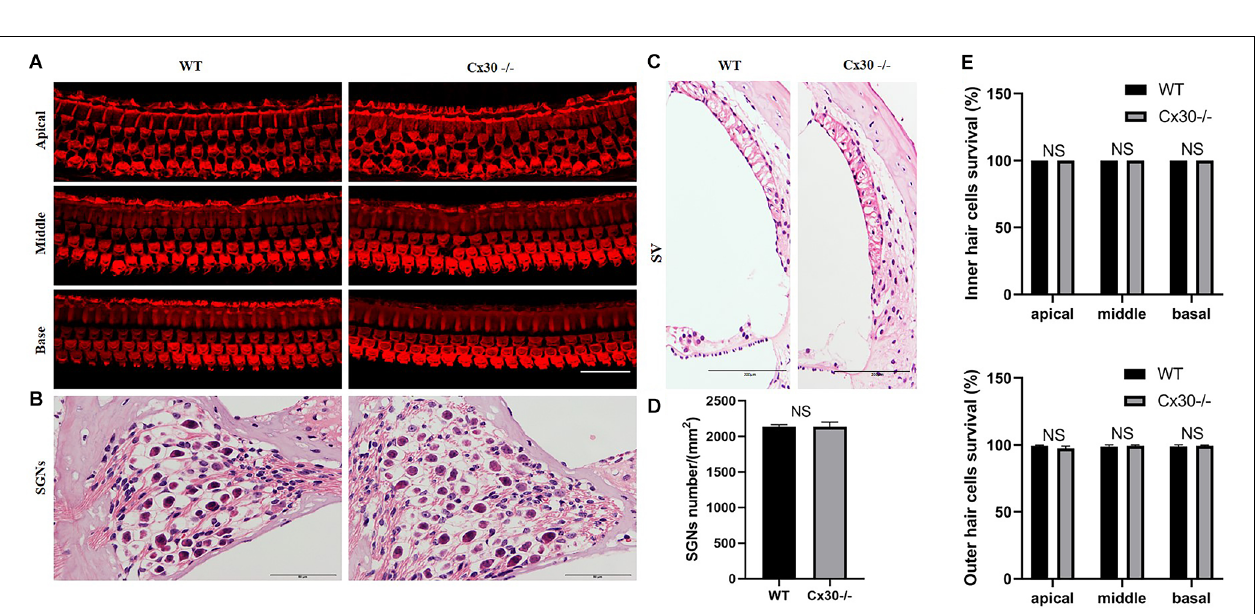
FIGURE 3 | The microscopic structure of cochlea in Cx30 -/- mice. (A,E) Whole-mountings of the apical, middle and basal turns of cochlear sensory epithelium in 1-month-old Cx30 -/- mice and WT mice were obtained by maximal intensity back-projection of 15 confocal optical sections from a 0.8 µ m step through—focus sequence (z-stack); actin filaments were stained with phalloidin (red); scale bar: 50 µ m. (B,D) HE staining of frozen sections of the cochlea in Cx30 -/- mice and WT mice showed no difference in the number of spiral ganglions (SGNs). Scale bar: 50 µ m. (C) HE staining of frozen sections of the cochlea in Cx30 -/- mice and WT mice showed no difference in the thickness of SV. SV, stria vascularis. Scale bar: 50 µ m. NS, not statistically significant. Data presented as Mean ± SEM. t